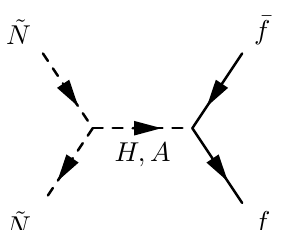
Figure 1 . The dominant annihilation mechanism of sneutrino DM in the